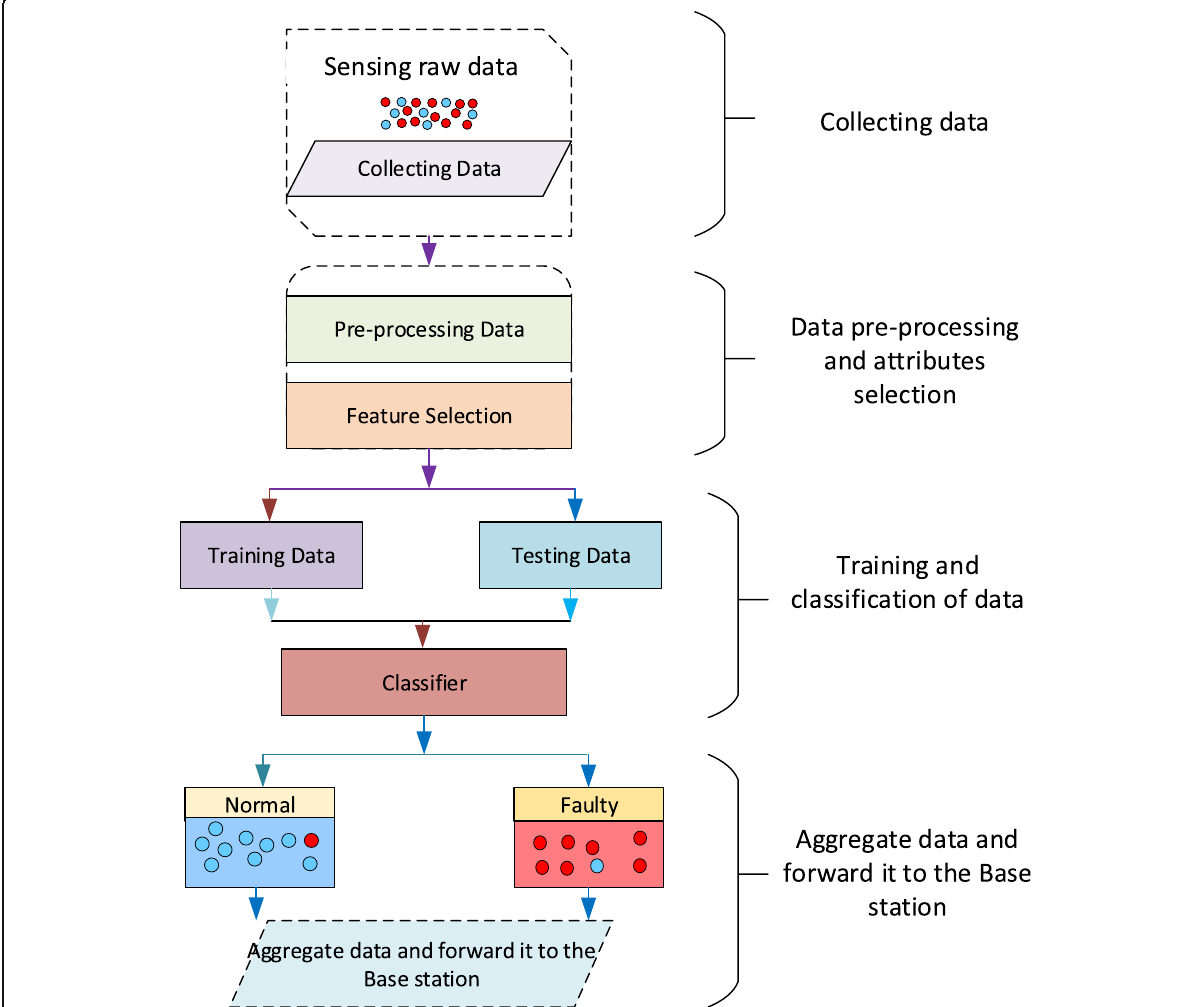
Fig. 4 The proposed fault detection scheme. The figure shows a flowchart of the steps in designing scheme involves the collection of data, pre- processing of data, identifying the fault, selecting the features and classification of